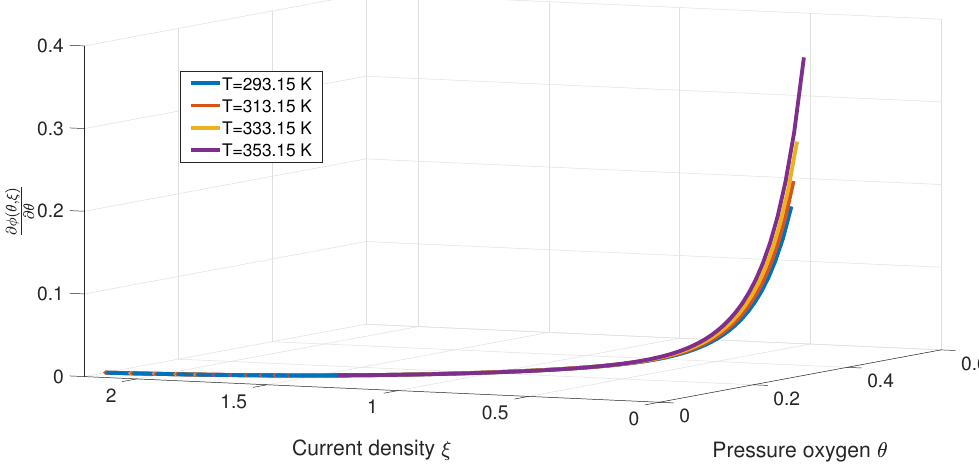
Figure 1. Behavior of the partial derivative of φ concerning θ